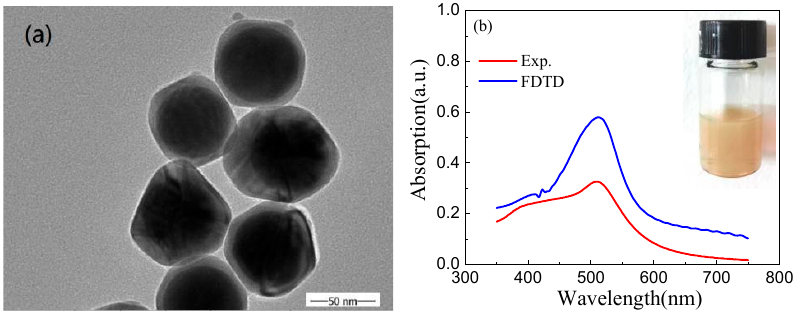
Figure 1. Characterization of the Au-Ag NPs. ( a ) TEM image. ( b ) Linear absorption spectra; inset image: photograph of the Au-Ag NPs’ water-soluble dispersion.